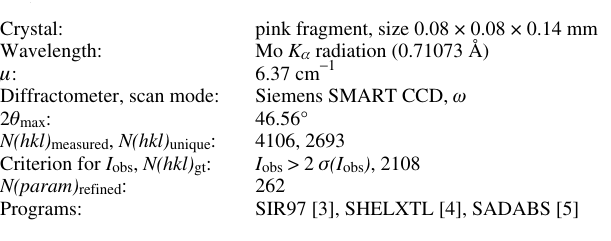
Table 1. Data collection and